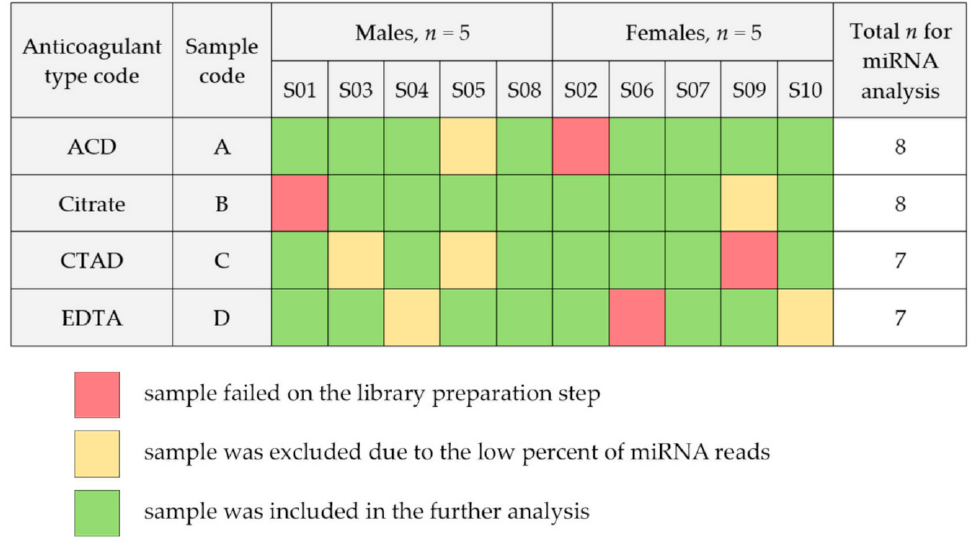
Figure 3. The study samples included in the further